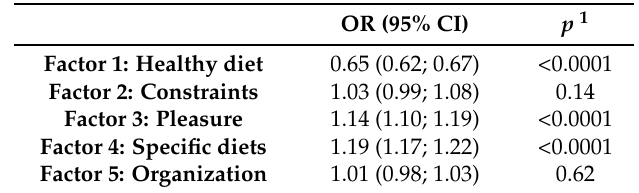
Table 3. Multivariate logistic regression analyses showing the association between dish choice motives and overweight (including obesity) in weekdays ( n = 50,003; NutriNet-Santé cohort